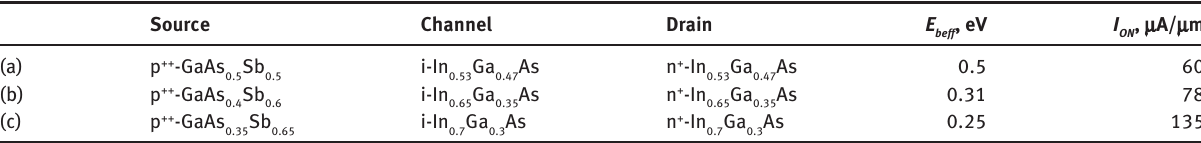
Table 1 Summary of structural information and device performance of GaAs tive tunneling barrier height [9,